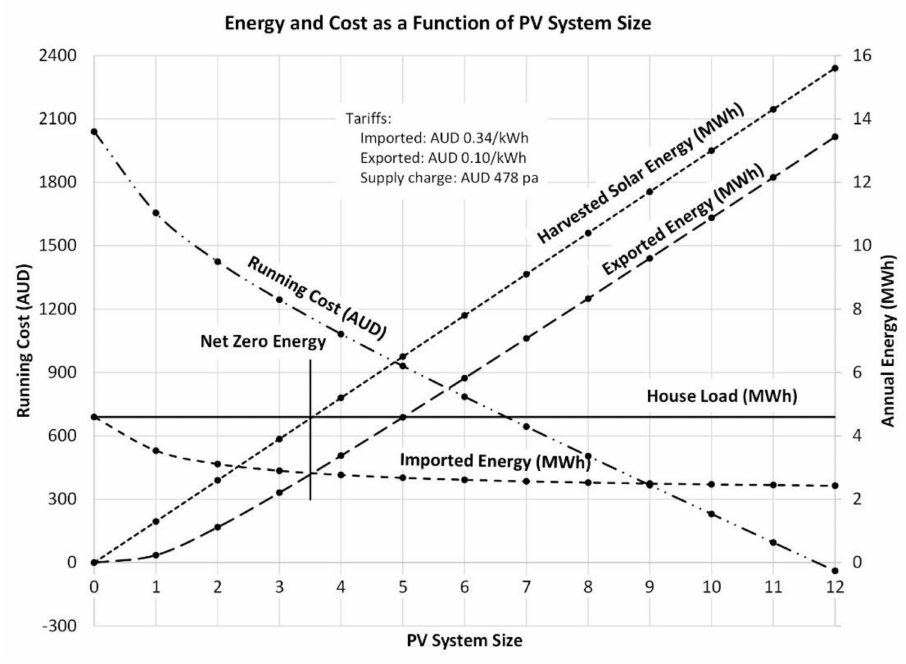
Figure 9. House 3: Energy flows and cost of electricity.